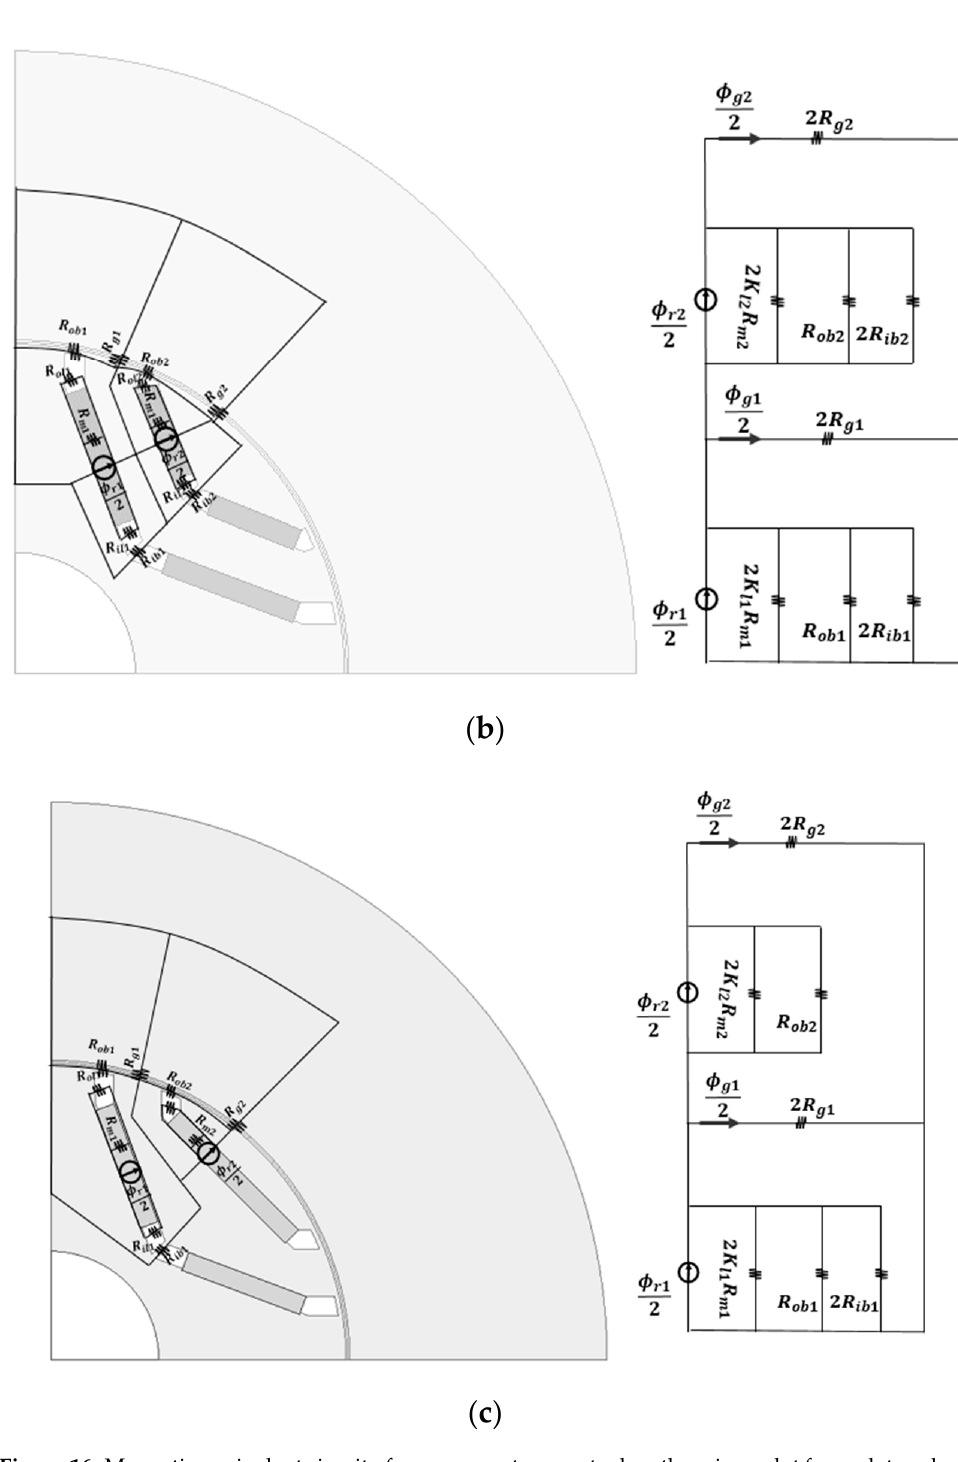
Figure 16. Magnetic equivalent circuit of a permanent magnet when there is no slot for each two-layer rotor: ( a ) DB, ( b ) DV, and ( c ) delta. Table 2. Equations of air gap flux density distribution parameters according to double-layer rotor type .